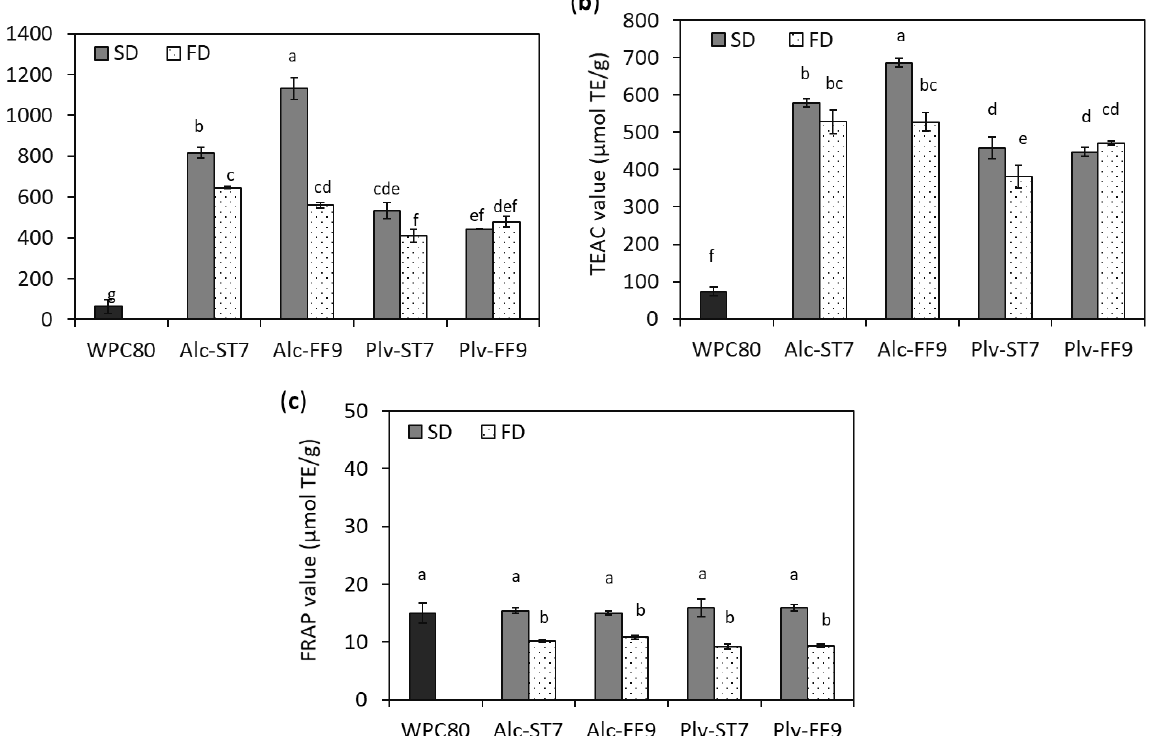
Figure 5. In vitro antioxidative activities, ( a ) oxygen radical absorbance capacity (ORAC), ( b ) Trolox equivalent antioxidant capacity (TEAC) and ( c ) ferric reducing antioxidant power (FRAP) of whey protein concentrate (WPC80) and spray-dried (SD) and freeze-dried (FD) whey protein hydrolysates prepared using Alcalase ® (Alc) and Prolyve ® (Plv) obtained under pH-stat at pH 7.0 (ST7) and free-fall pH 9.0 (FF9) hydrolysis conditions. Results represent mean ± SD ( n = 3), where different letters indicate significant difference at p < 0.05.